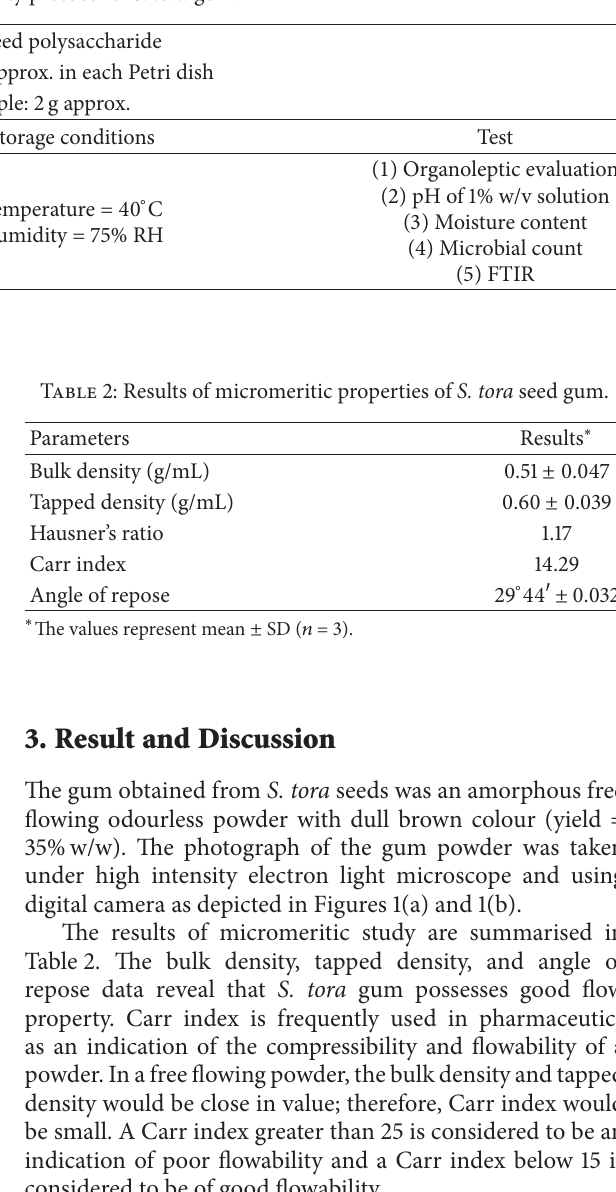
Table 1: Accelerated stability protocol of S. tora gum.